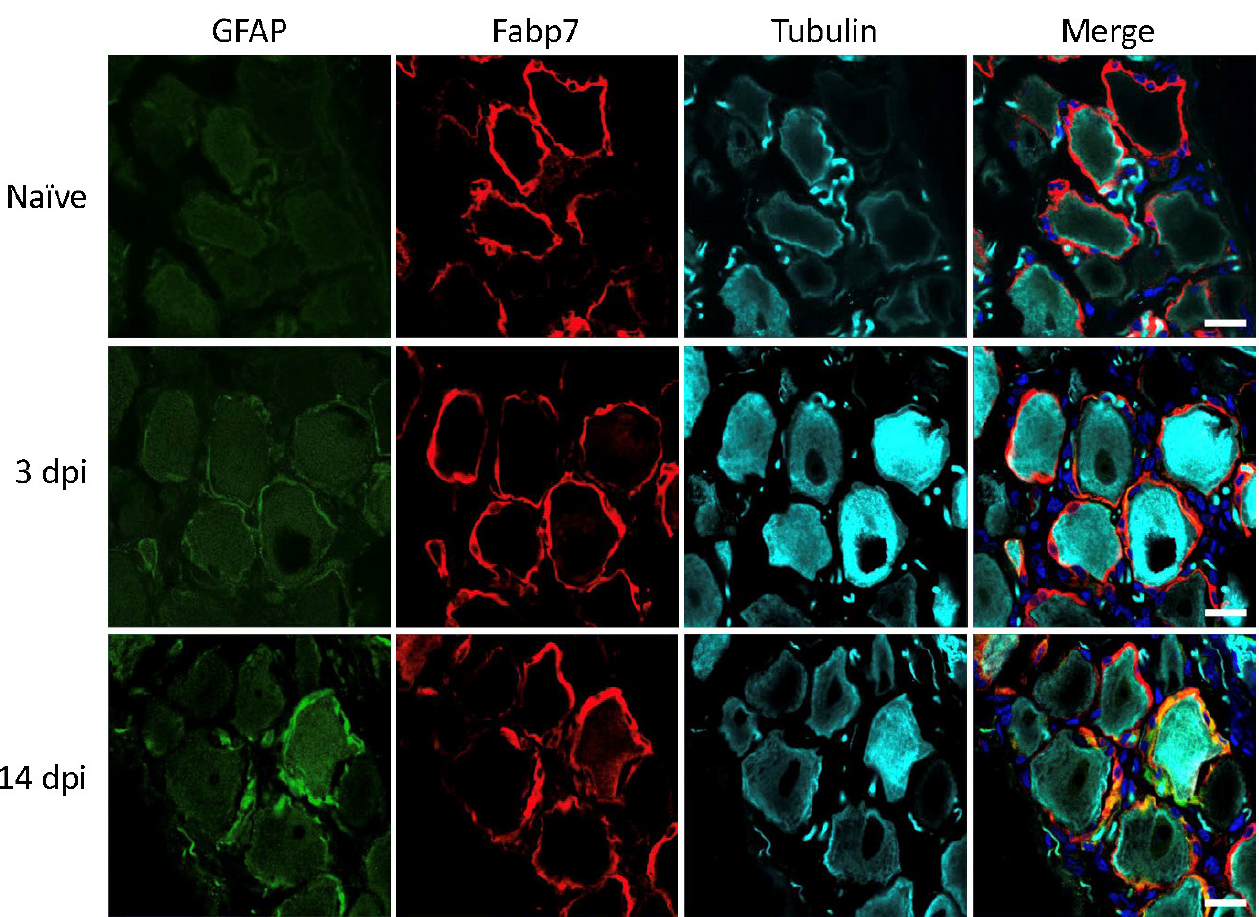
Figure 3. Rat lumbar DRG 3- and 14-days post injury (dpi). GFAP (green), SGC marker Fabp7 (red), neuronal b-tubulin (magenta), and Hoechst nuclear marker (dark blue, merge only). Scale bar = 20 μ m.